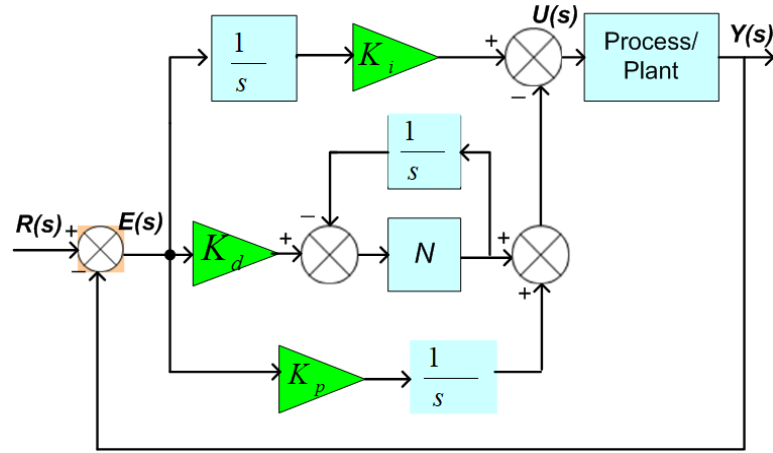
Figure 5. Configuration for the I-PDF controller.